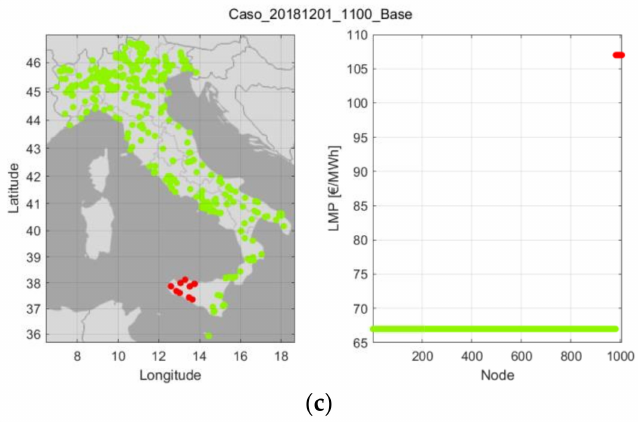
Figure 19. LMPs case 01.12.2018, 11:00, Base: ( a ) N1cor scenario; ( b ) N1cor scenario; ( c ) N70 scenario.